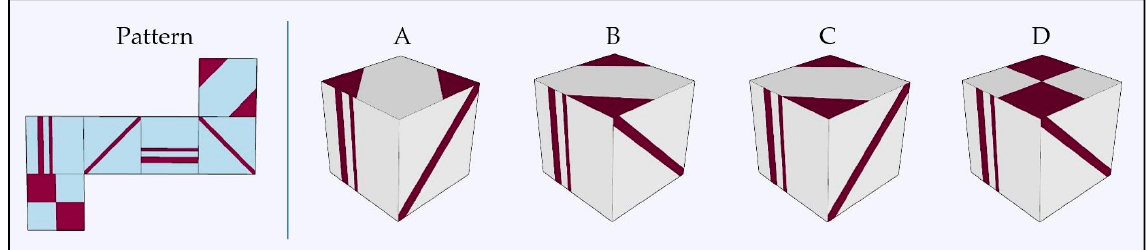
Figure 4. DAT:SR sample question. Figure 4. DAT: SR sample